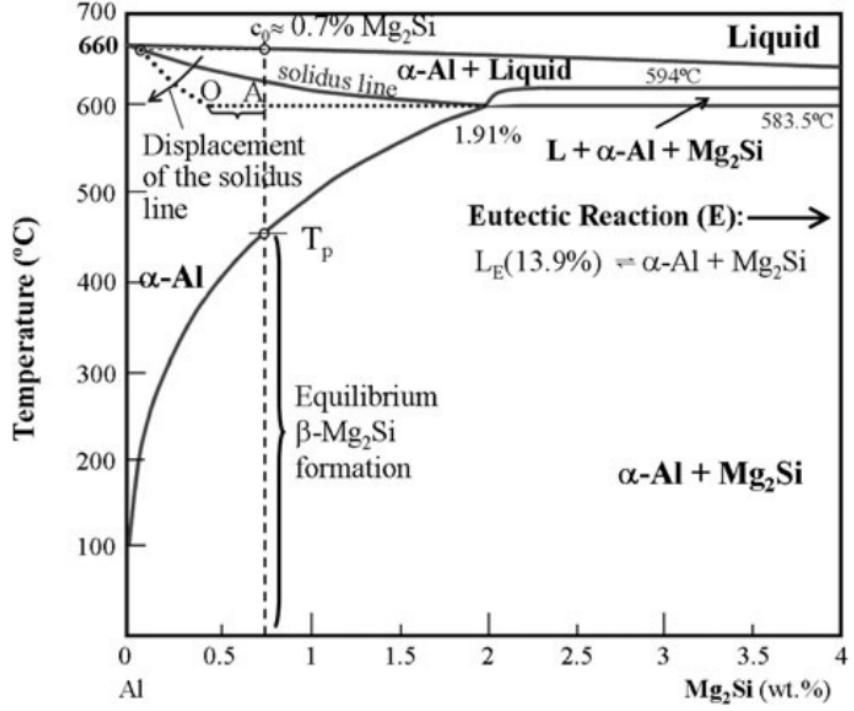
Figure 20. Pseudo ‐ binary Al ‐ Mg2Si phase diagram illustrating the possibility of the formation of Figure 20. Pseudo-binary Al-Mg2Si phase diagram illustrating the possibility of the formation of coarse eutectic Mg2Si under non ‐ equilibrium conditions [15,25]. coarse eutectic Mg2Si under non-equilibrium conditions